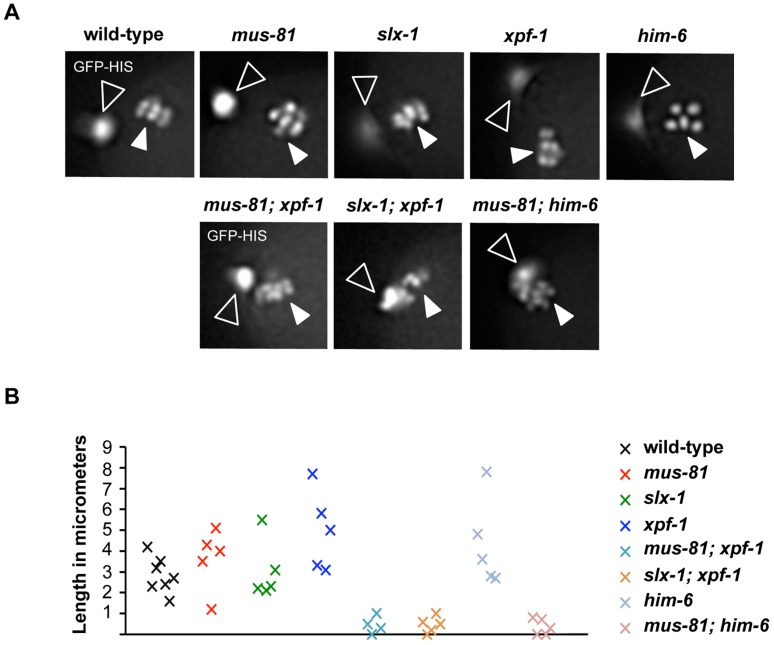
Impaired chromosome segregation during meiosis.(A) Representative images taken from time-lapse recordings of GFP-Histone H2B expressing embryos. Images were taken during metaphase of meiosis II. Open arrowheads indicate the first polar body; filled arrowheads indicate chromosomes aligned on the metaphase plate. Note five chromosomes in the him-6 panel indicating chromosome missegregation. (B) Graph depicting the distance between the first polar body and the metaphase plate one minute prior to the onset of anaphase II. A minimum of five embryos were analysed for each genotype.